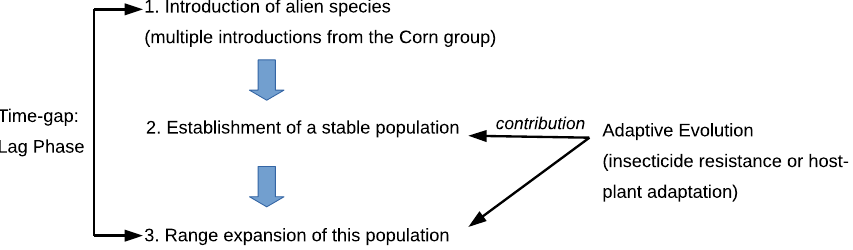
Figure 5. Models of the invasive process in FAW First, FAWs were introduced from the Corn group between sfC and sfR, possibly multiple times. Second, a stable population was established in a location in the Old World. This population experienced growth in size, and FAW invasion was first reported. Third, range expansion occurred from this population. The first step occurred before 2016, implying the existence of a lag phase. Adaptive evolution contributed to the second and third steps, potentially through insecticide resistance or host plant